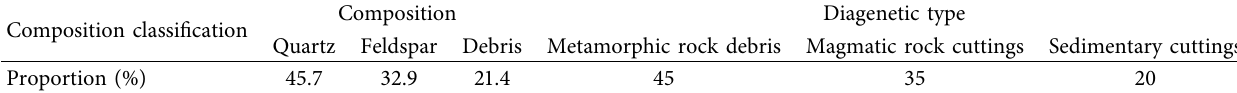
Table 3: Composition and diagenetic types of reservoir debris.